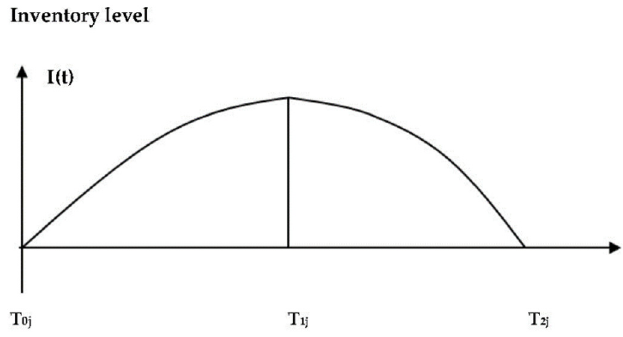
Figure 1. Inventory level of manufacturer under learning and forgetting.